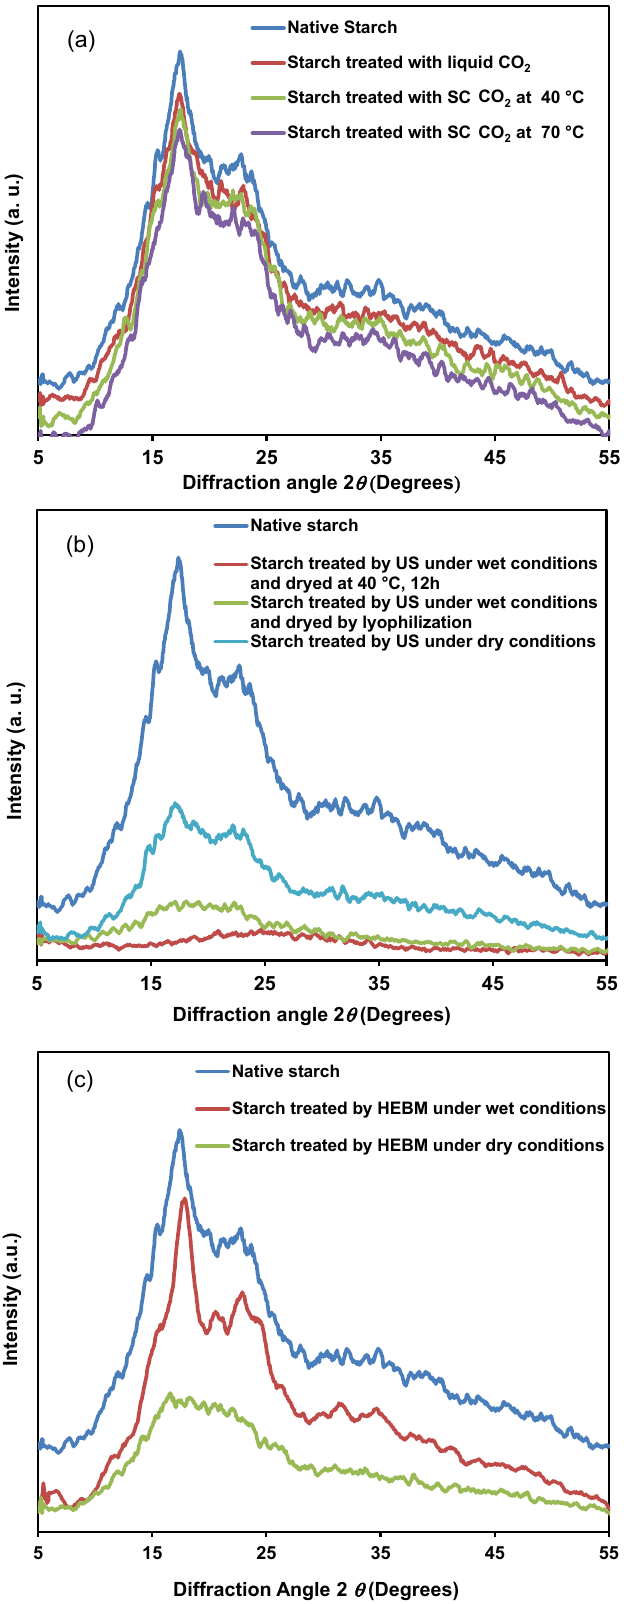
Figure 1. X-ray powder diffraction patterns of ( a ) native and treated starch using liquid and su- percritical CO 2 ; ( b ) native and treated starch using ultrasonication; ( c ) native and treated starch using